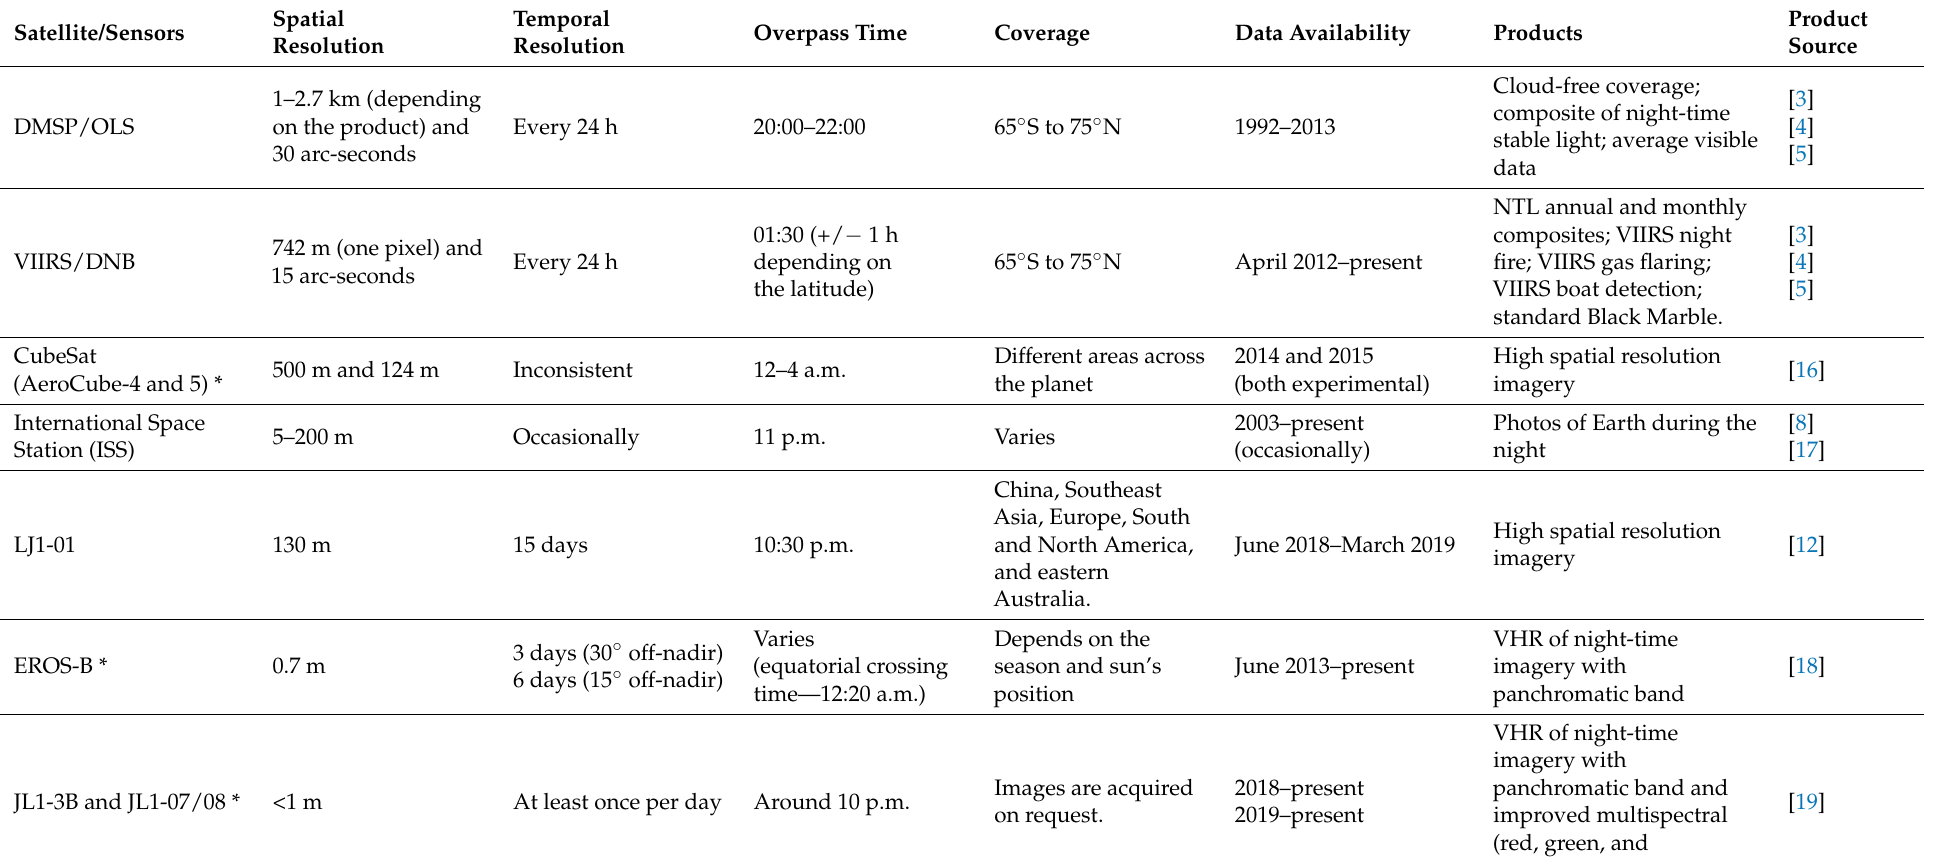
Table 1. Satellite and Sensor capabilities in capturing